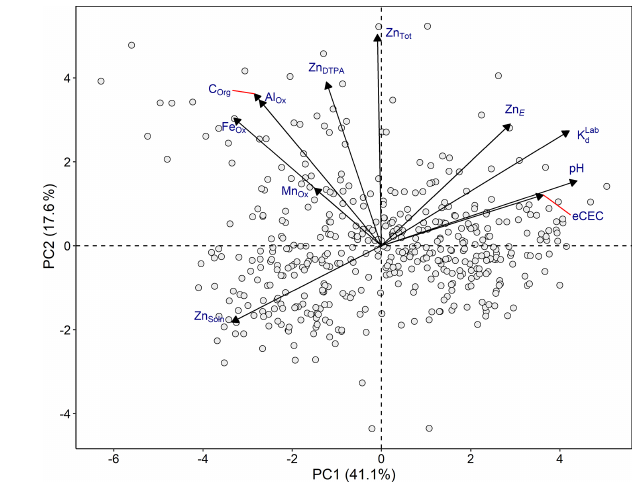
Figure 3. Principal component analysis of main soil variables and Zn